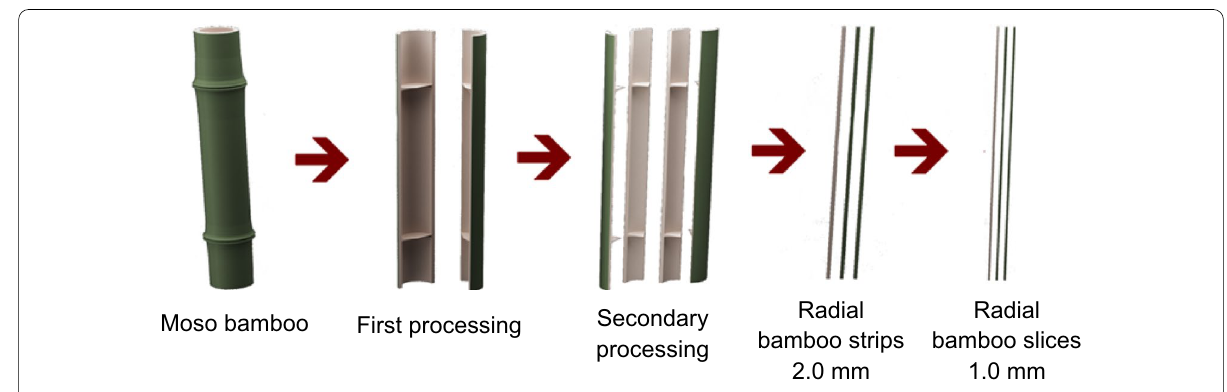
Fig. 2 Flow diagram of manufacturing radial bamboo